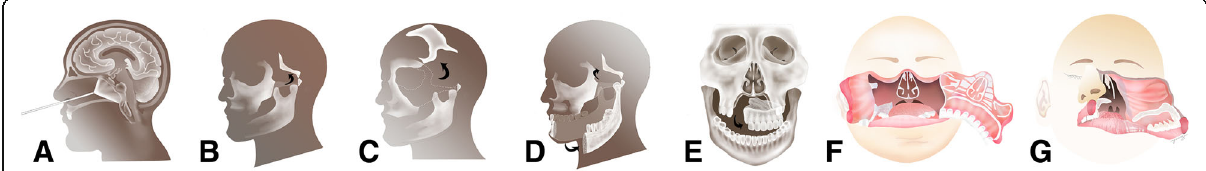
Fig. 1 Schematic drawings of representative skull base approaches showing the endoscopic endonasal approach ( a ), the transzygomatic approach ( b ), the orbitozygomatic approach ( c ), the zygomatico-transmandibular approach ( d ), the transmaxillary approach ( e ), the facial translocation approach ( f ), and the midfacial degloving approach ( g